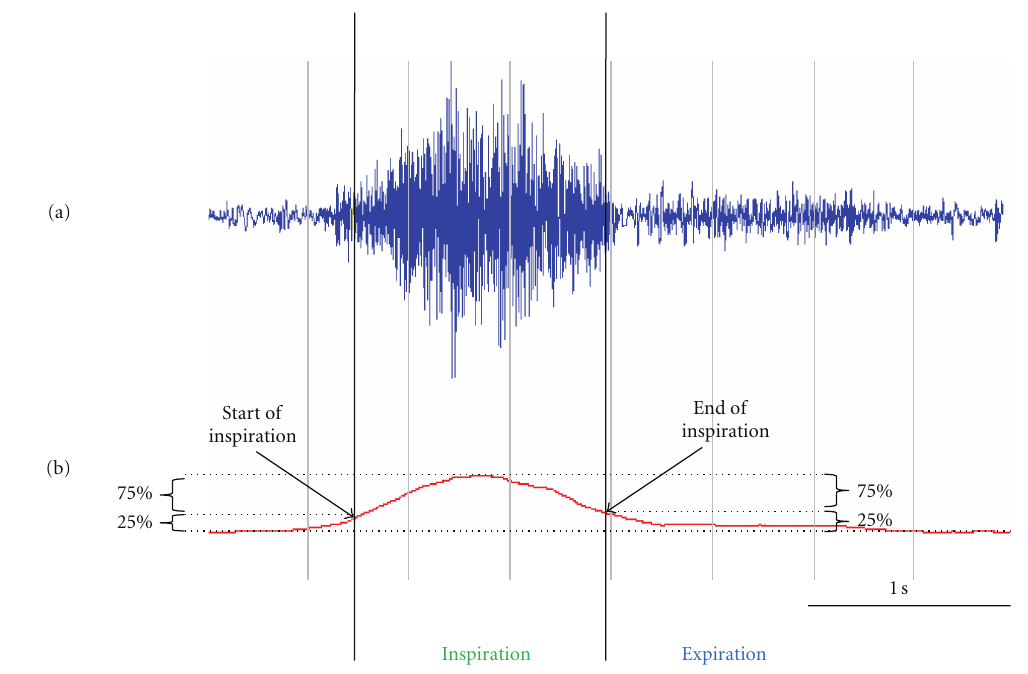
Figure 2: Identification of the start and end of inspiration. (a) A time-amplitude plot of a single channel breath sound band pass filtered between 80 Hz and 500Hz. (b) The running average of the absolute value of the time amplitude signal. The start of inspiration was defined as the time when the signal reached 25% of its maximum level (left vertical line). The end of inspiration was defined as the time when the signal just dropped below 25% of its maximum value (right vertical